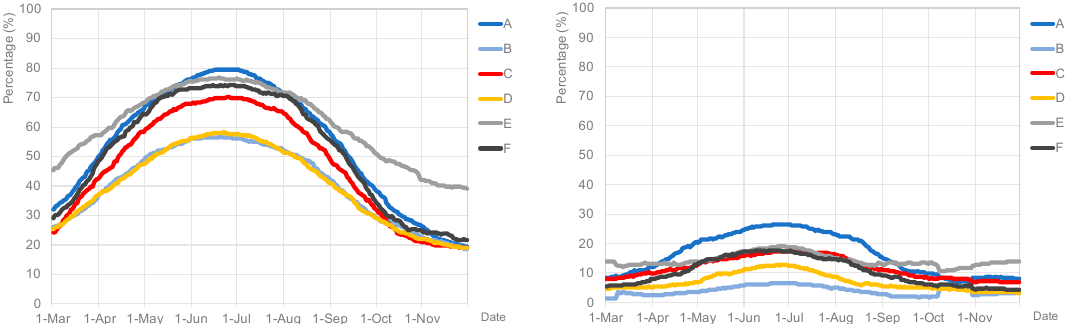
Figure 10. Percentages of ground-level surface with direct sunlight for three or more hours ( left ) and six or more hours ( right ) from March to November for study sites A to F when FAR is 3.5.